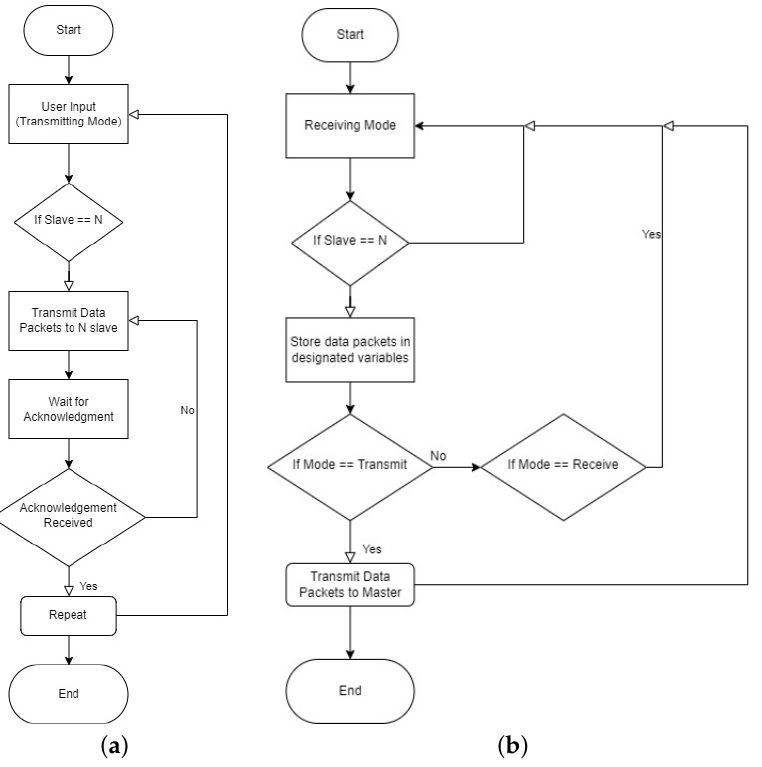
Figure 6. RS485-based ( a ) Raspberry Pi Master and ( b ) Arduino Uno slave communication flow